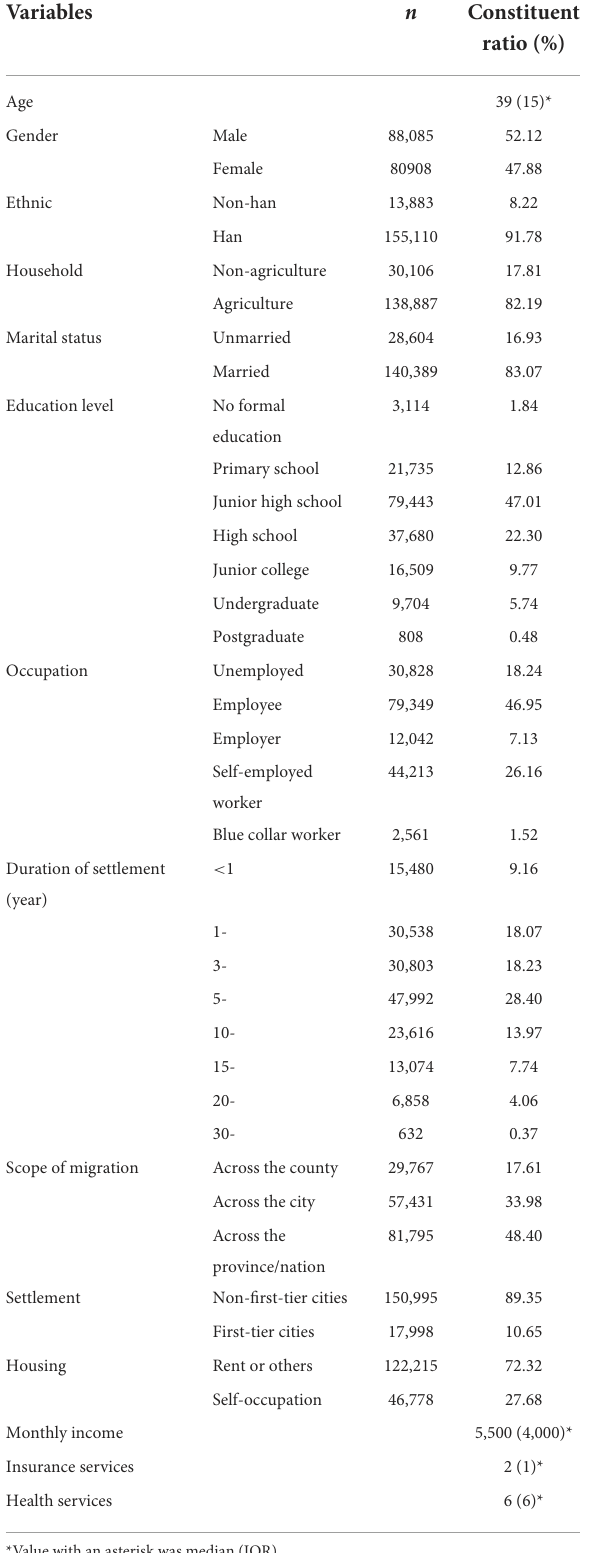
TABLE 2 Basic information of the floating